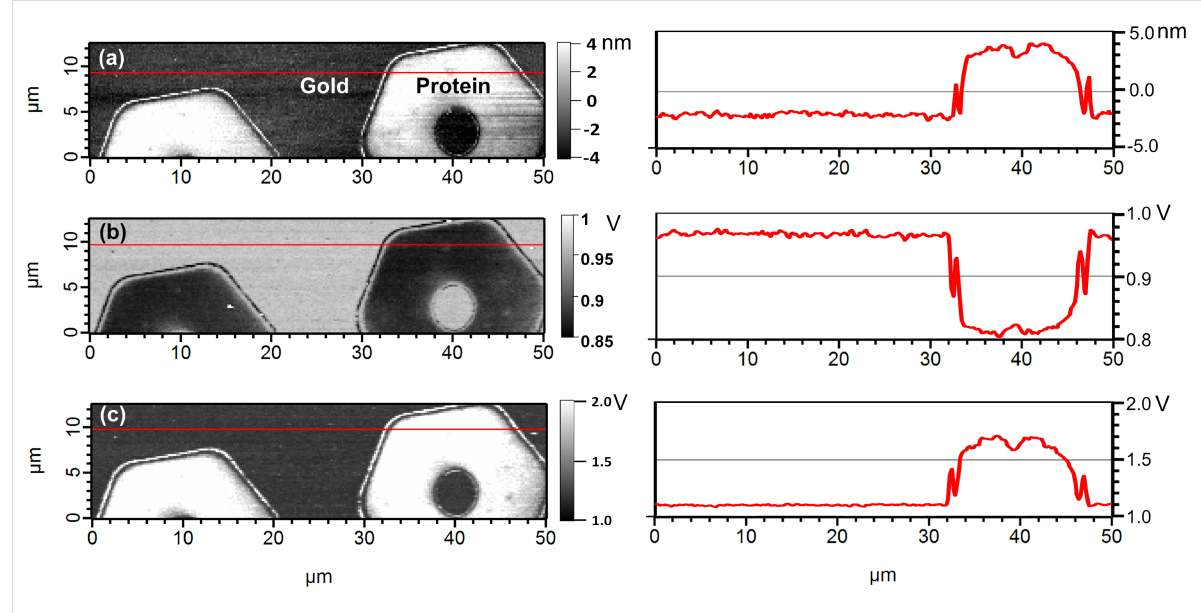
Figure 3: FMM images of SpA-N B-domain protein patterns on a gold surface, with corresponding cross-section analysis along the red line in the AFM images. (a) The height image shows a protein height of about 5 nm. (b) The amplitude and (c) phase images of the same area clearly show the elastic difference between protein and the gold